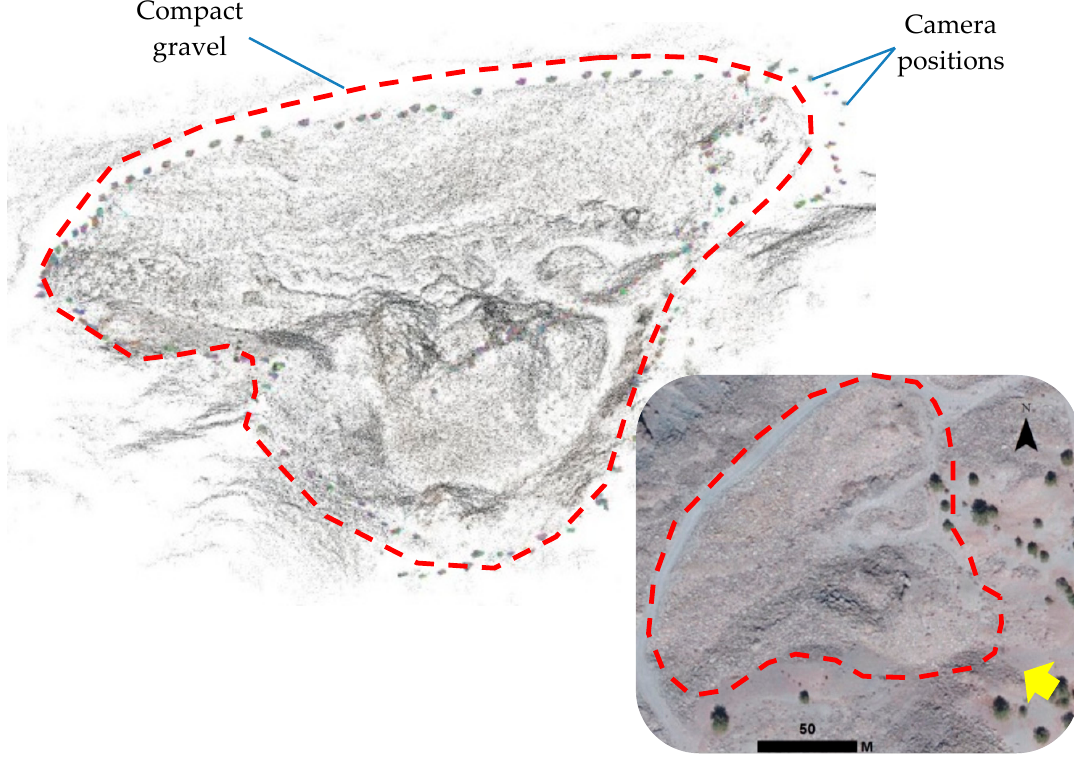
Figure 4. 3D rendering of the point cloud from the photographs taken during the field campaign. The majority of gray-colored points represent rhyolite blocks and grains, where camera locations are lightly colored spheres along the perimeter of usable data (outlined in red). Inset: WorldView-2 image of “the Bowl” area on the North Coulee (inset is shown lower right). The yellow arrow shows the directional perspective of the 3D point cloud rendering.